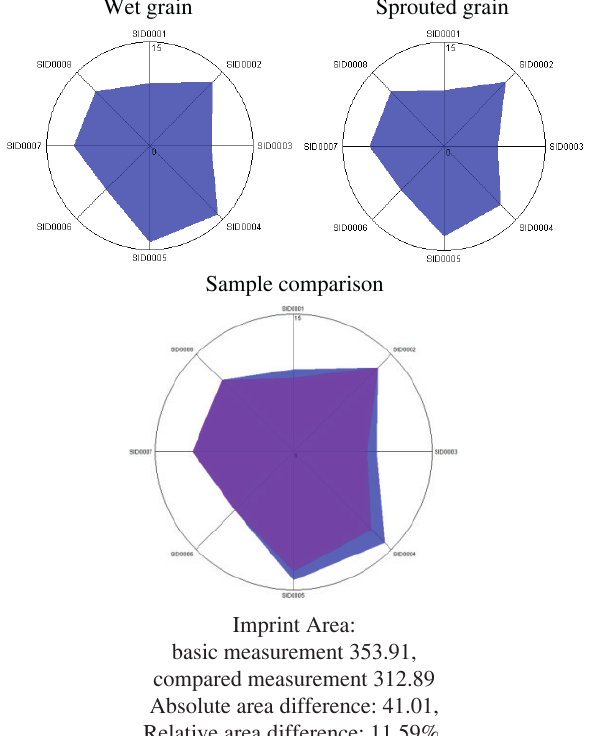
Figure 4 “Visual prints” of the maximum sensor signals in the equilibrium gas phase above the samples. The rotary axis indicates the numbers of the sensors in the array (experimental part), and the vertical – the responses of the sensors at a particular point in time (ΔFmax,